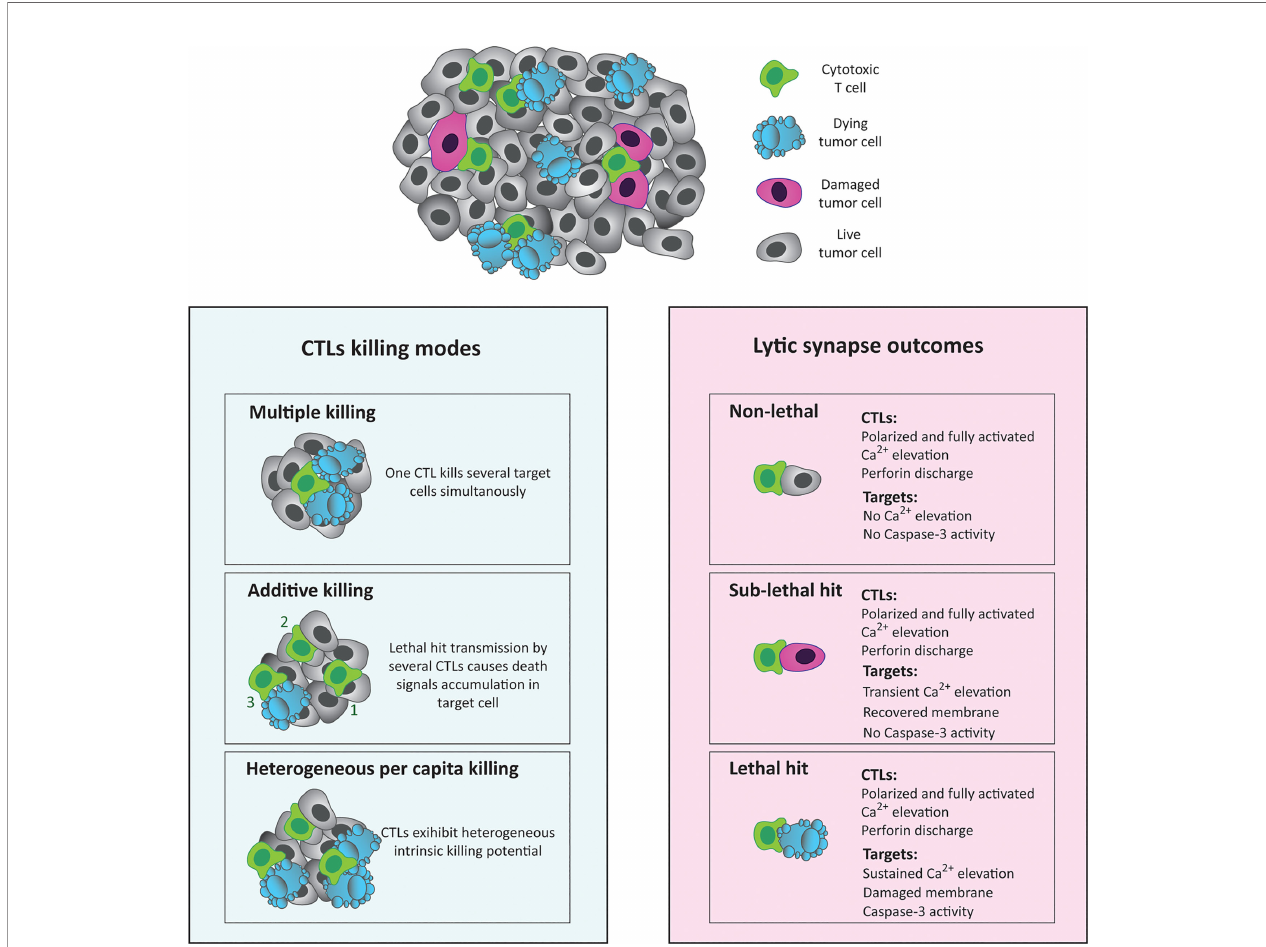
FIGURE 1 | Different scenarios of CTL/target cell interaction. The left panel depicts different modes of CTL-mediated killing. CTLs eliminate tumor cells via a combination of killing modes, including multiple killing (one CTL kills several targets) or additive killing (several CTLs kill one target through the accumulation of intracellular damage). Furthermore, CTLs exhibit heterogeneous killing capacities ranging from high to low per-capita killing potential. The right panel illustrates individual outcomes at the lytic synapse between a given CTL and target cell. These encounters can be divided into three categories: non-lethal (in which full CTL activation does not trigger any response in target cell), sub-lethal (in which the target cell receives a CTL death signal but manages to resist the lethal outcome), and at last the lethal encounters (in which a CTL accomplishes complete annihilation of the target